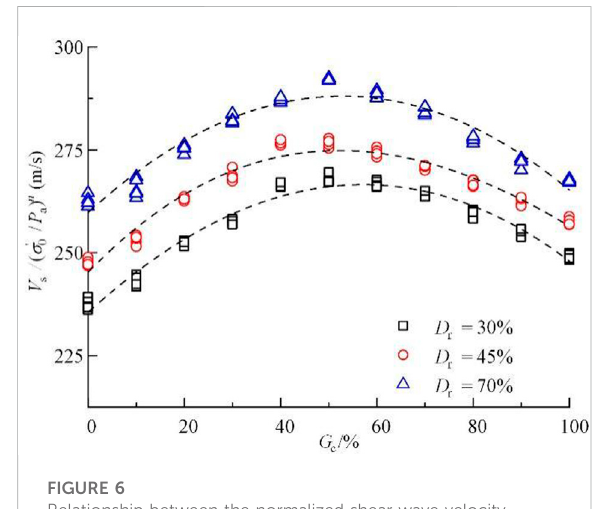
FIGURE 6 Relationship between the normalized shear wave velocity and the G c of the mixtures.